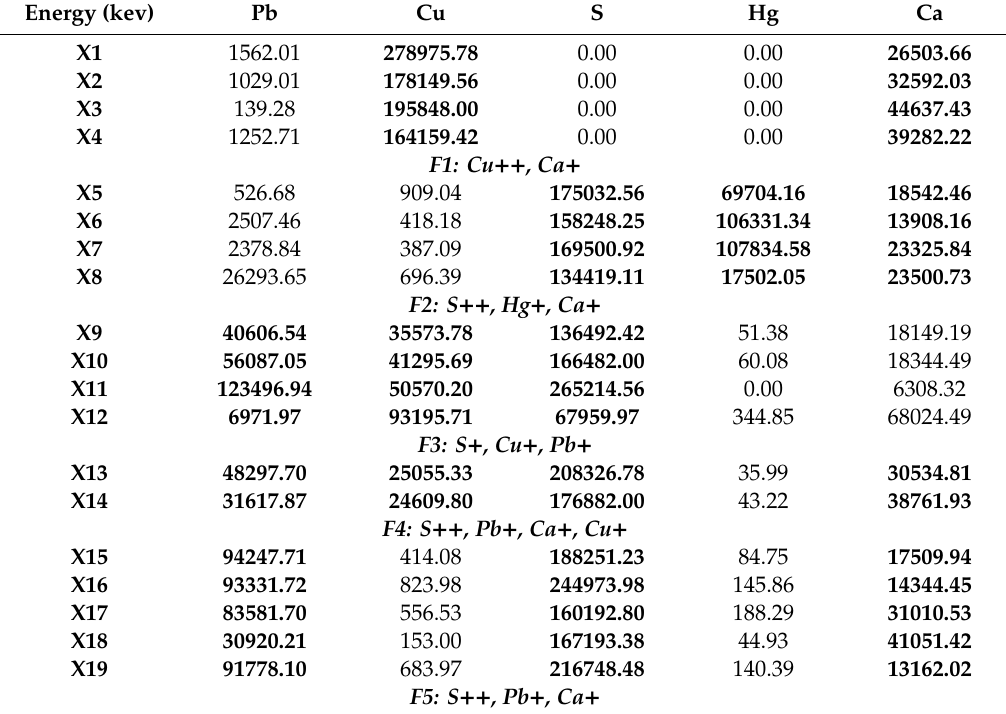
Table 9. Elements detection results by using XRF on the fresco.